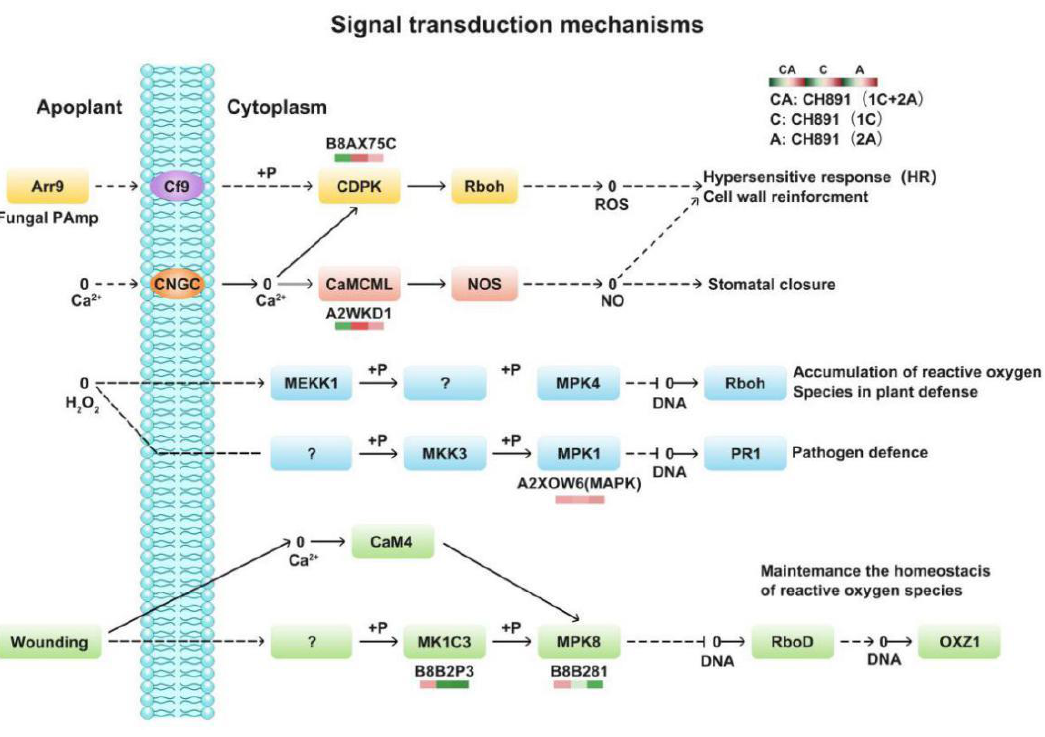
Figure 8. Changes in quantified proteins associated with the signal transduction mechanisms in three transgenic lines (NIL groups) and control lines (left box: CH891(1C+2A)/CH891, center box: CH891(1C)/CH891, right box: CH891(2A)/CH891).